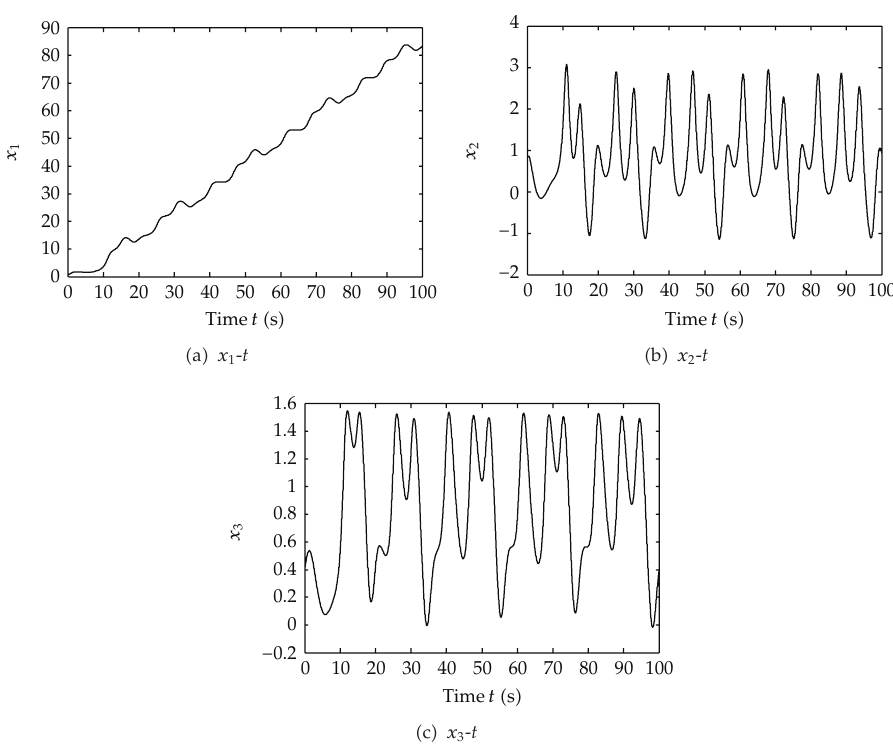
Figure 3: The time domain charts of state variables without